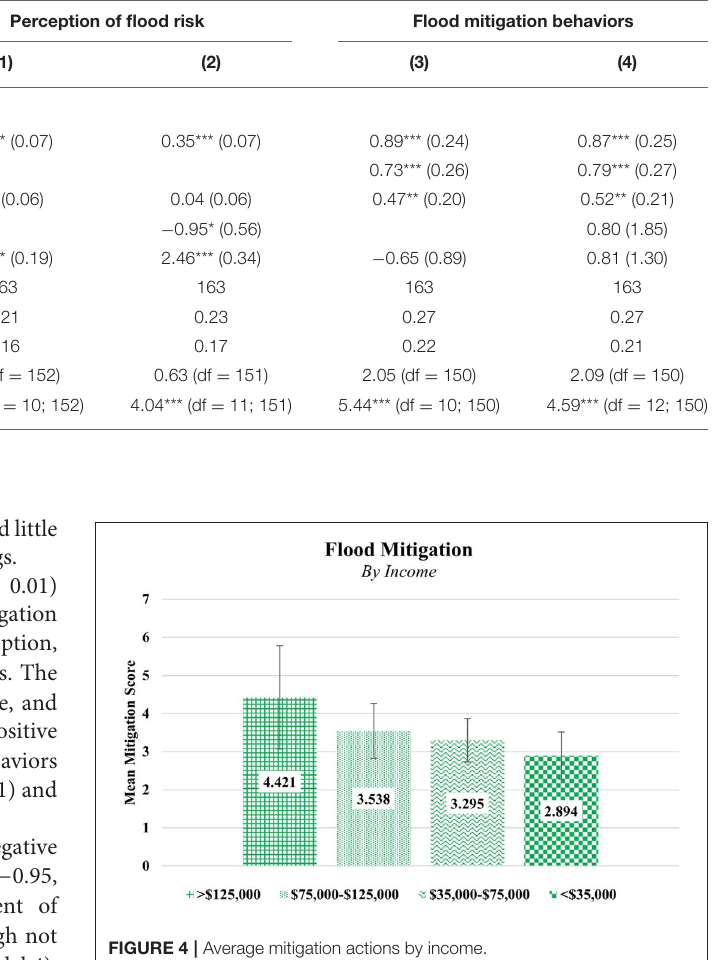
finding—that social capital is a significant factor predicting